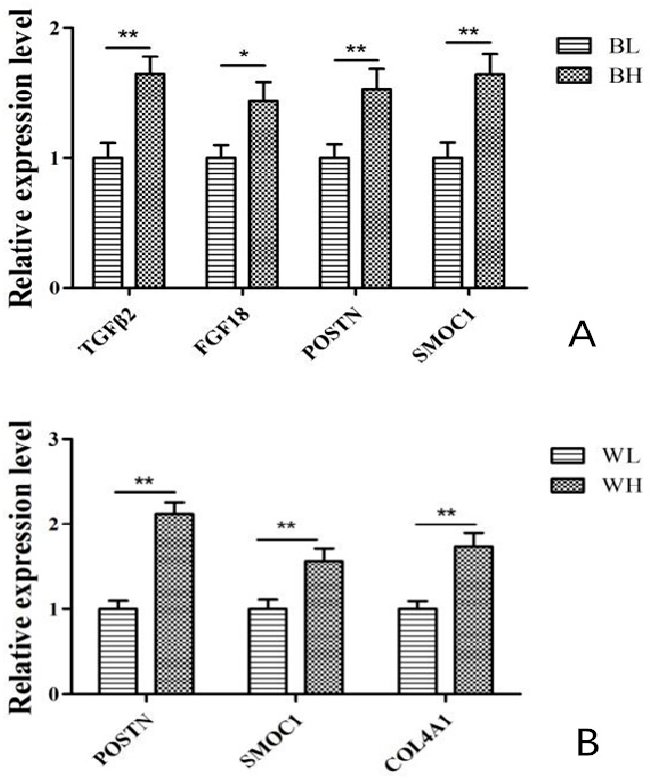
Figure 6. qPCR validation of DEGs in ( A ) BL-vs-BH and in ( B ) WL-vs-WH. The results were expressed as mean ± SD, * for p < 0.05, ** for p < 0.01.